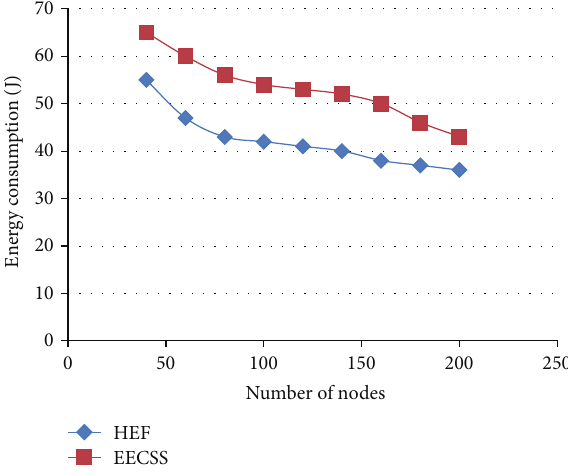
Figure 7: Number of nodes versus energy consumption.